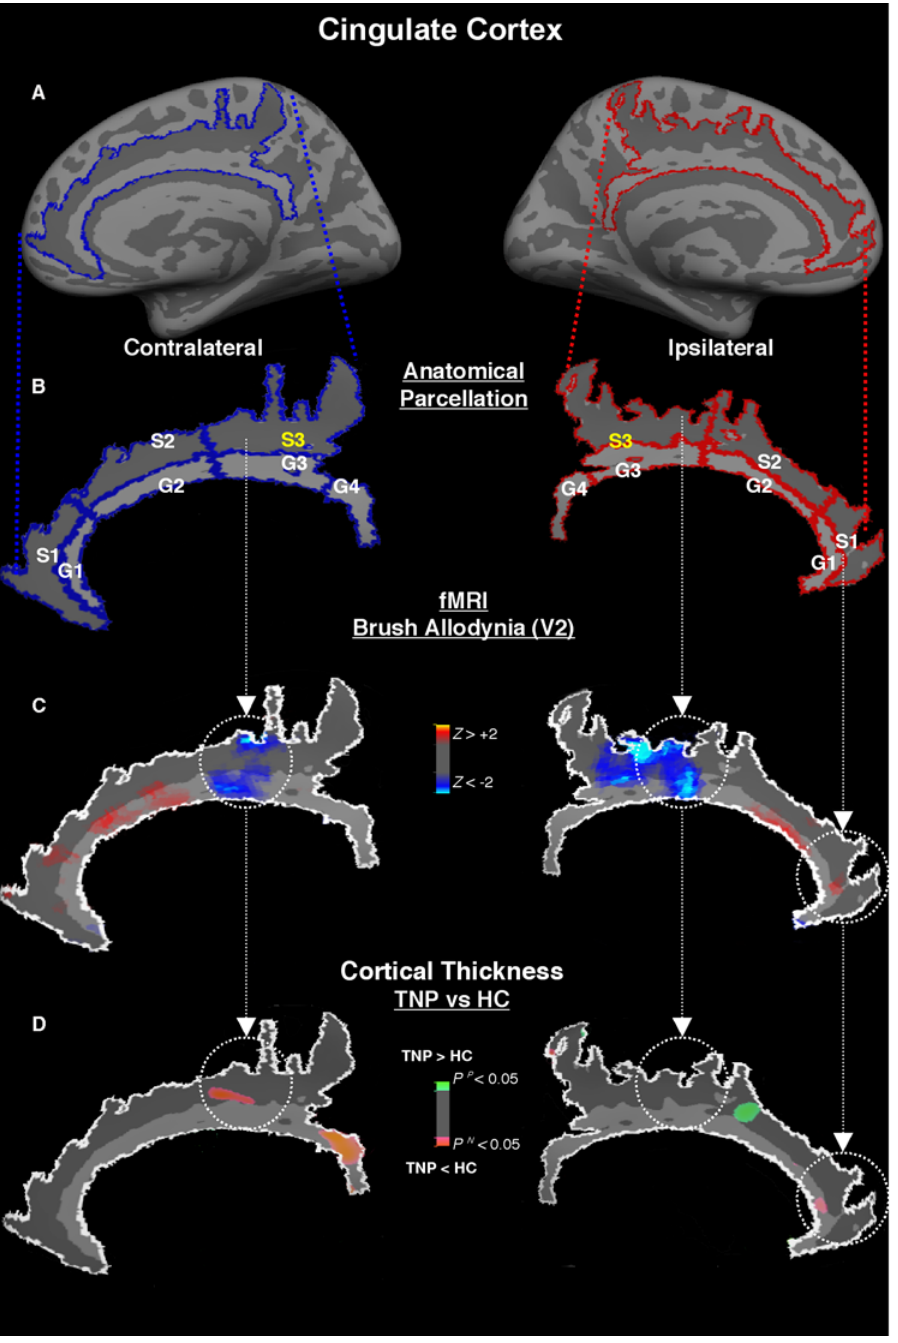
Figure 4. Cingulate Cortex (CC). Panel A and B - CC was manually and individually segmented in seven different sections based on folding pattern and structural landmarks. Panel C - Average BOLD (de)activations in the contralateral and ipsilateral CC during allodynic brush of the affected V2 of the six TNP patients. The results show functional deactivation in the posterior medial CC (pMCC) (sections S3) and activation in the more anterior regions of CC (ACC), as well as the retrospl. Panel D –Differences in cortical thickness between TNP and HC along sections of the sensorimotor cortex (red=TNP . HC; green=TNP , HC). We found thickening and thinning in pMCC in the contralateral and ipsilateral hemispheres respectively. There was also thinning in the anterior and retrosplenial CC. Functional (de)activation colocalized with cortical thickness changes in the contralateral pMCC and in the ipsilateral ACC. doi:10.1371/journal.pone.0003396.g004 compared to the same region in HC (p , 0.007). This thinning patients, when compared to HC in the antero-mid cingulate sulcus spatially coincided with BOLD deactivation during allodynic (putative BA 32’/24’) ipsilateral to allodynic pain (p , 0.009), as brush stimulation of the affected V2 region ( Figure 4C ). In an well as thinning in the contralateral retrosplenial cortex (p , 0.001). opposite fashion, significant cortical thickening was found in TNP However, these structural findings did not spatially coincided with